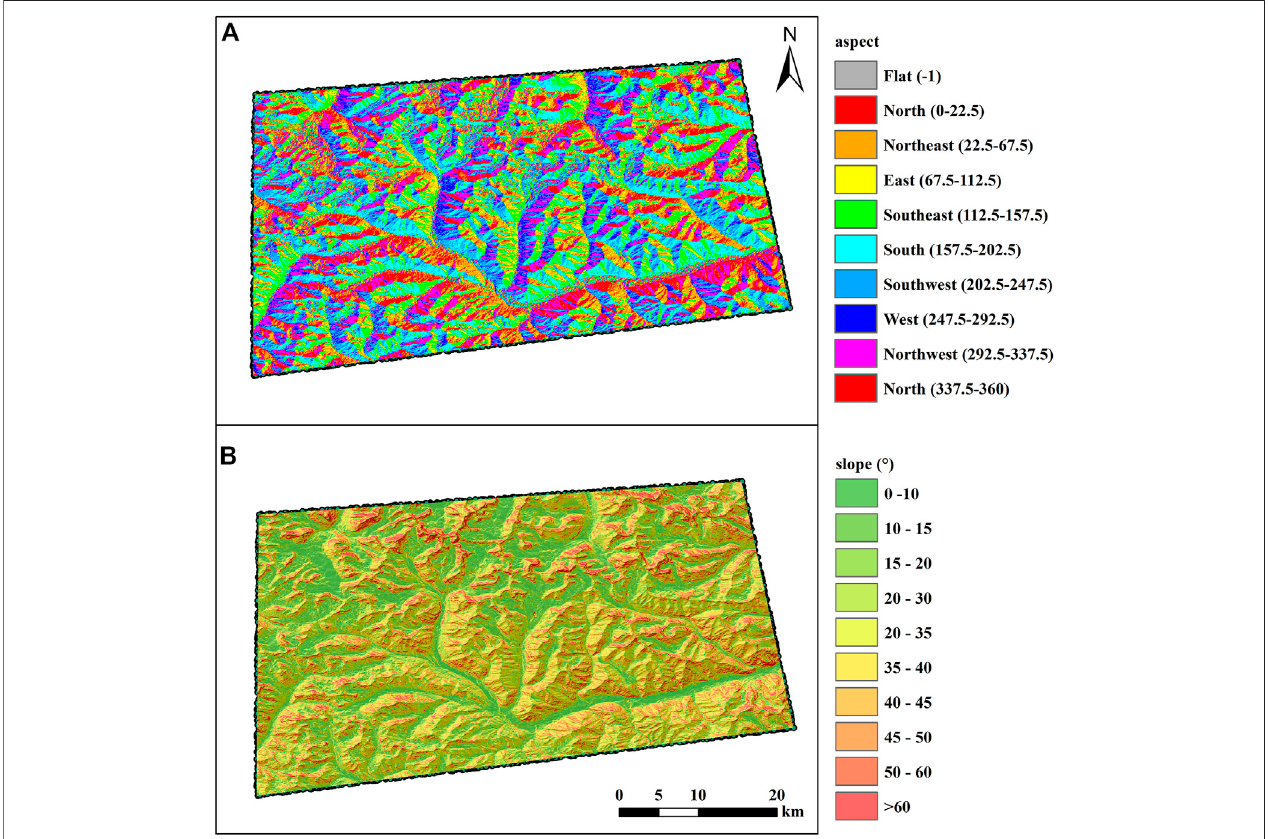
FIGURE2| Groundsurfacetopographicalinformationofstudyarea[ (A) showstheaspectinformationand (B) istheslopedata,andallareproducedfromtheDEM dataset].